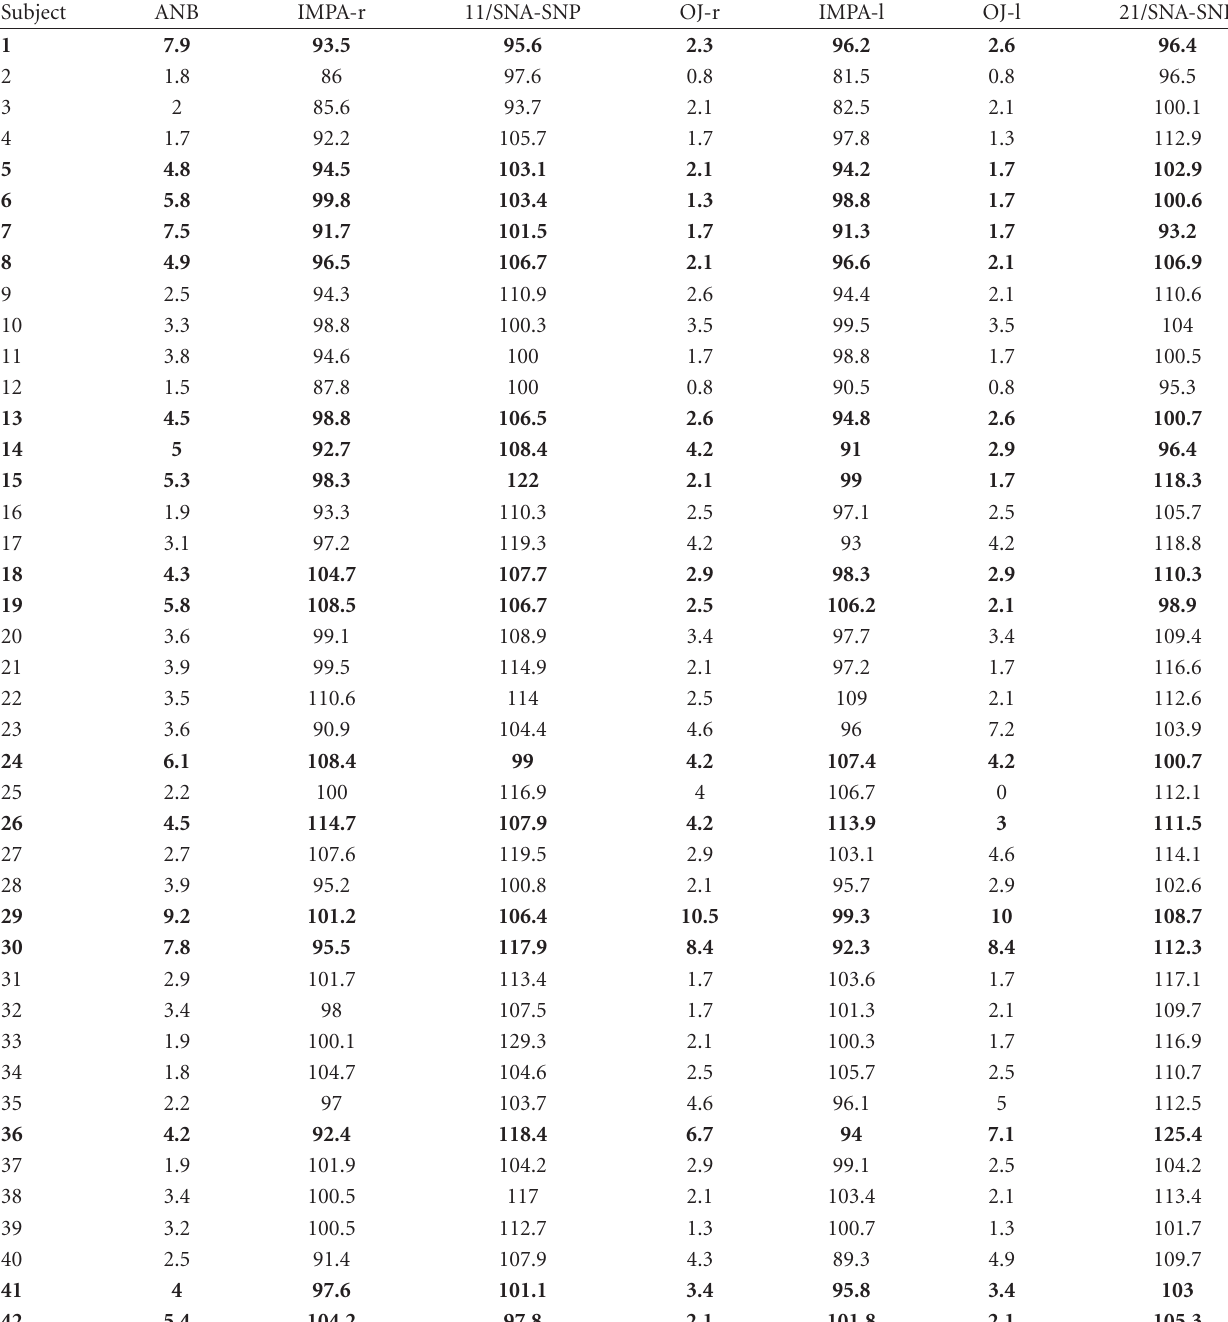
Table 2: Initial measurements of the entire sample revealed. In bold ANB > 4, in regular font ANB